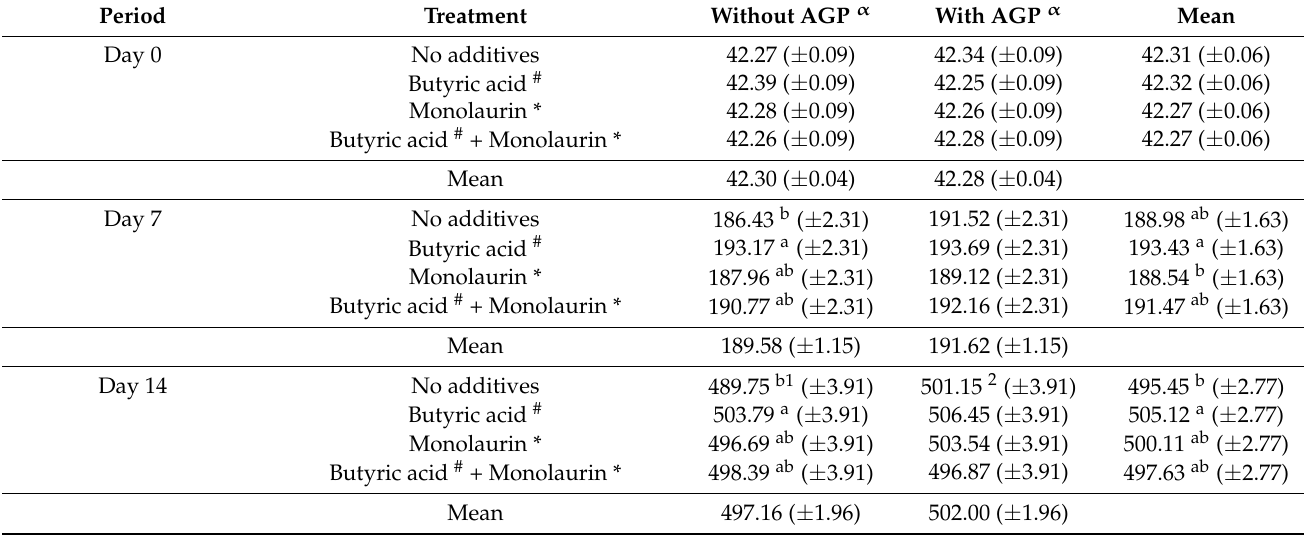
Table 1. The effect of butyric acid and α -monolaurin, with and without the inclusion of an antibiotic growth promoter, on weekly body weight (g) of broilers ( ± standard error of the